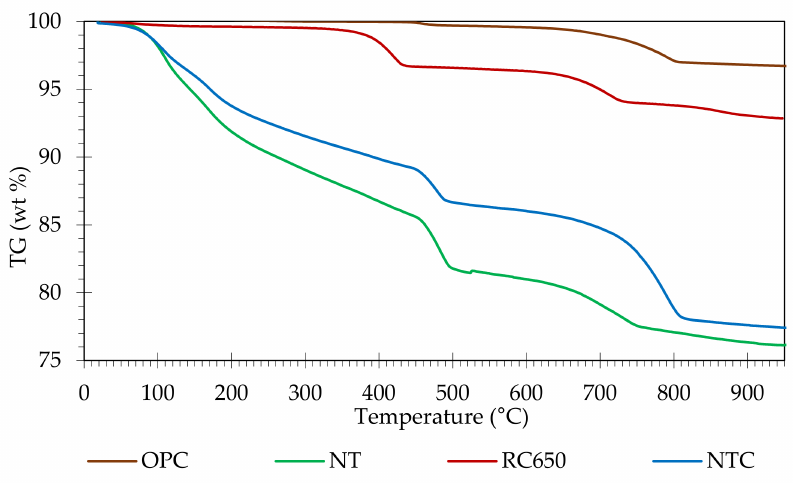
Figure 2. Thermogravimetric analysis of OPC, recycled cement paste (RCP), non-treated cement paste (NT) and non-treated concrete cement paste